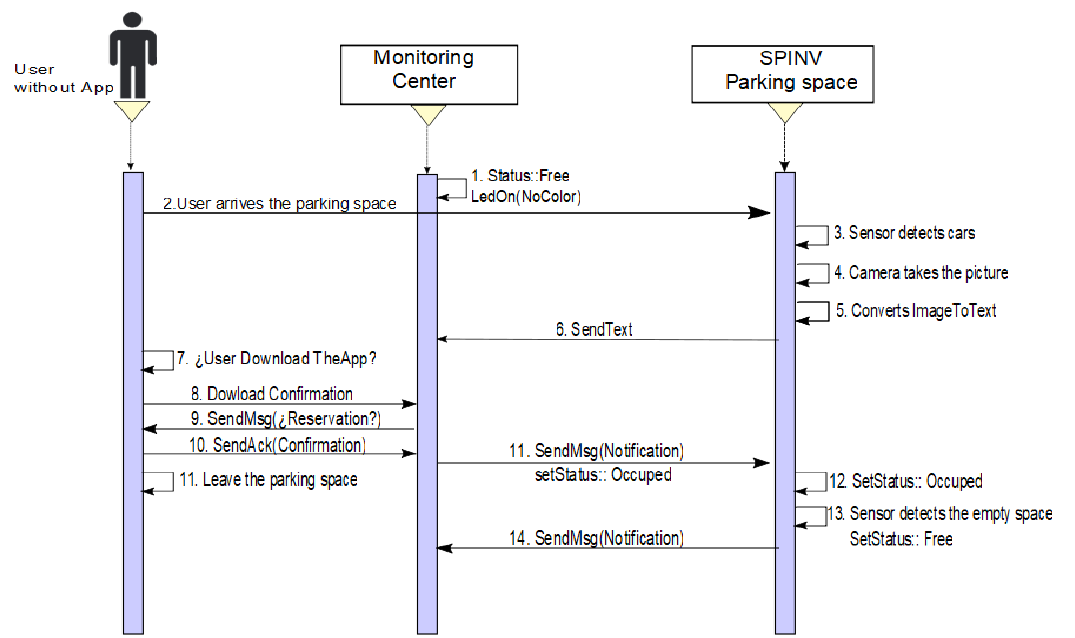
Figure 10. Sequence diagram of Scenario 3b. There is no reservation, a car arrives to the space, and the user/driver does not have the app.